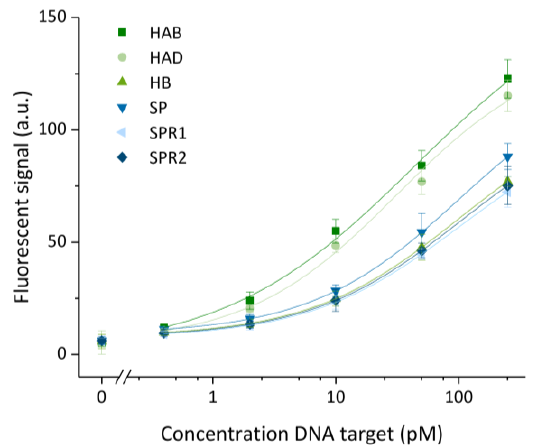
Figure 5. Calibration curves obtained for six different targets (HAB, HAD, HB, SP, SPRR1 and SPR2) for a 5-fold diluted concentration range from 250 to 0.4 pM, including a blank. Hybridization chain reaction was performed for 60 min. Data were fitted with an adjusted R 2 of ≥ 0.98 for all targets. The error bars represent one standard deviation ( n = 3).